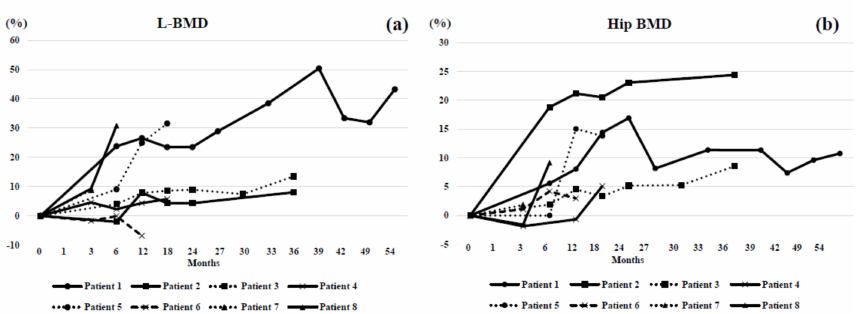
Figure 1. Changes in bone mineral density (BMD) before and during denosumab administration. ( a ) In most cases, the percent changes in lumbar 1–4 spine BMD (L-BMD) were positive during the follow-up period. In Patient 6, L-BMD was decreased at 12 months. In Patient 2, L-BMD was decreased until 6 months. ( b ) In most cases, the percent changes in bilateral hips BMD (H-BMD) were positive during observation. In Patient 4, H-BMD was decreased at 3 and 12 months. In Patient 8, H-BMD was decreased until 3 months. Patient 1: circles connected by a solid line. Patient 2: squares connected by a solid line. Patient 3: squares connected by a dotted line. Patient 4: cross marks connected by a solid line. Patient 5: circles connected by a dotted line. Patient 6: cross marks connected by a hashed line. Patient 7: triangles connected by a dotted line. Patient 8: triangles connected by a solid line. Circles, squares, and triangles represent family